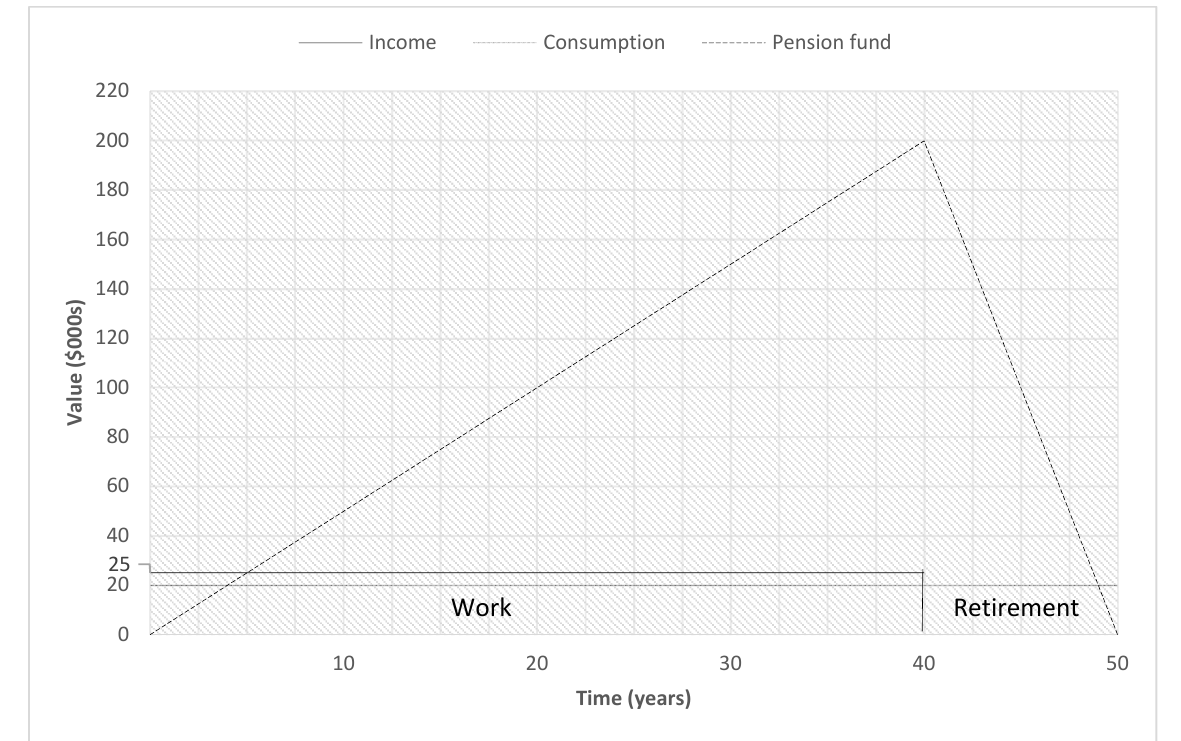
Figure 1. The lifecycle model of consumption with retirement savings in a pension fund.